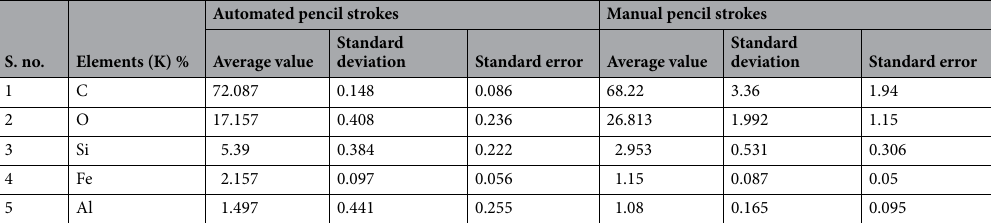
Table 1. Detail summary of EDX characterization for automated and manual pencil strokes on porous nature Whatman filter paper (Gr 1) with standard deviation (n = 3).